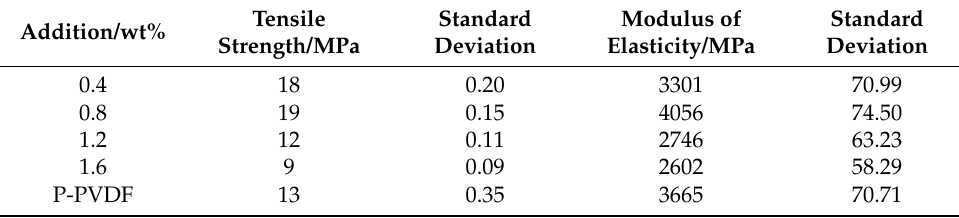
Table 8. Mechanical properties of the fiber membrane at different loading of FeCl 3 · 6H 2 O.